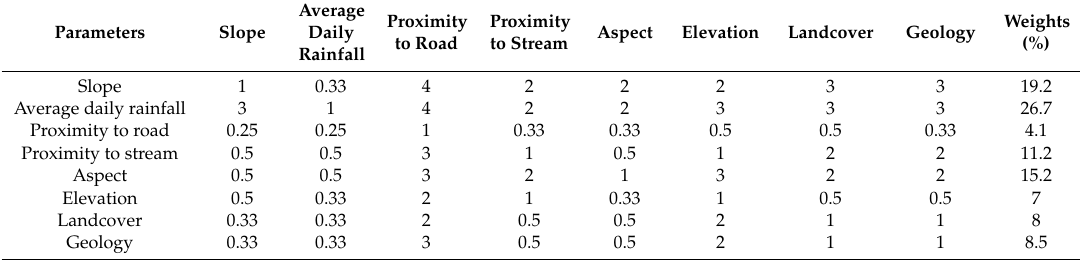
Table 3. Parameter Wise Weights, Matrix, and Consistency Ratio as Determined Using AHP.